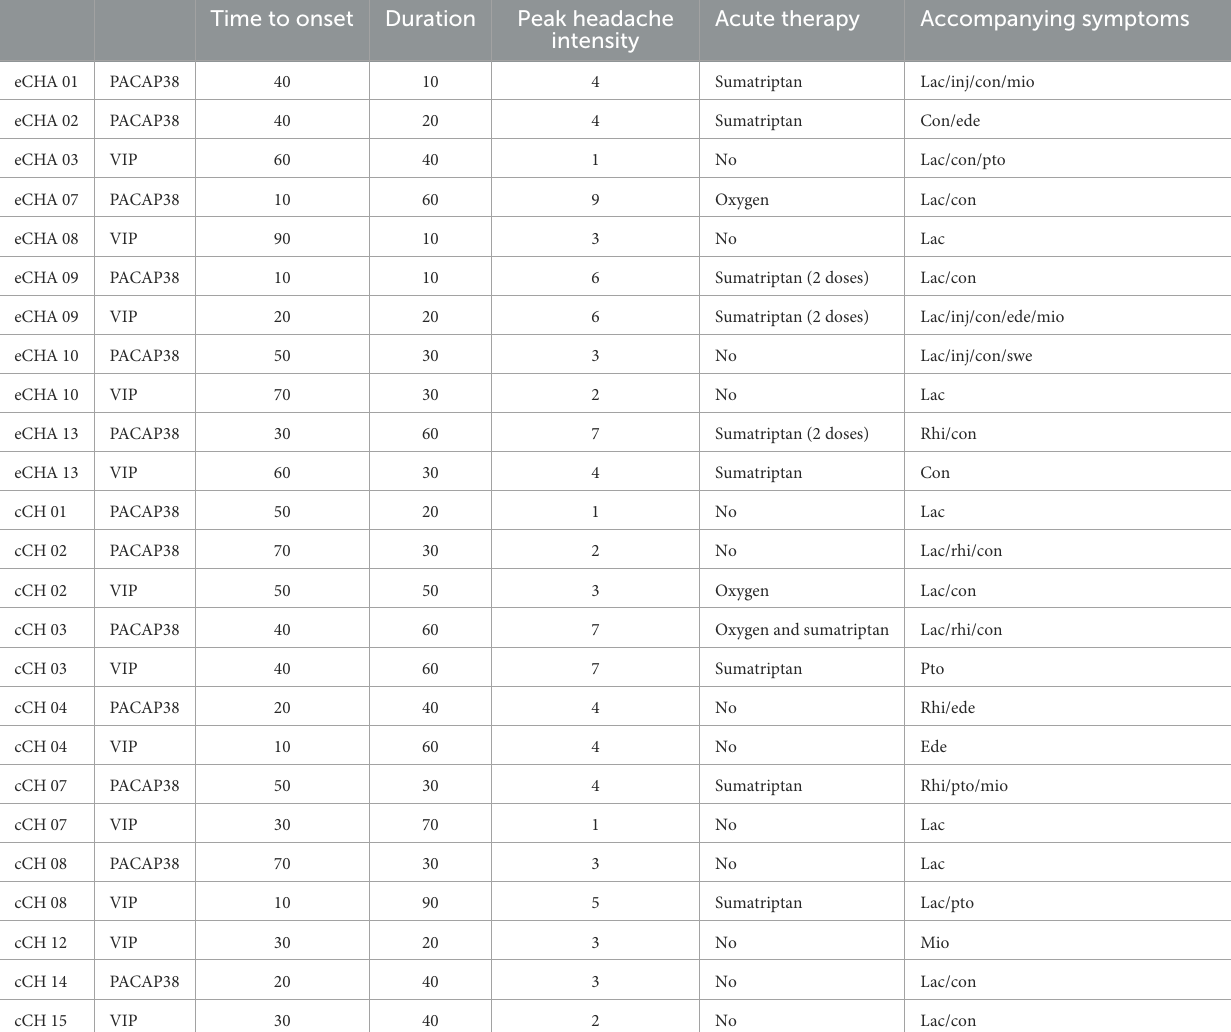
TABLE 2 Clinical characteristics of PACAP- and VIP-induced cluster headache. Time to onset Duration Peak headache Acute therapy Accompanying symptoms intensity